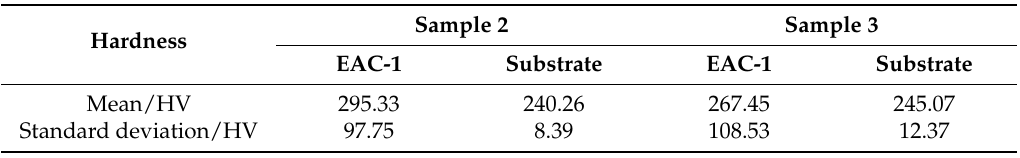
Table 4. Average hardness values and corresponding standard deviations of substrates and deposited EAC-1 films.